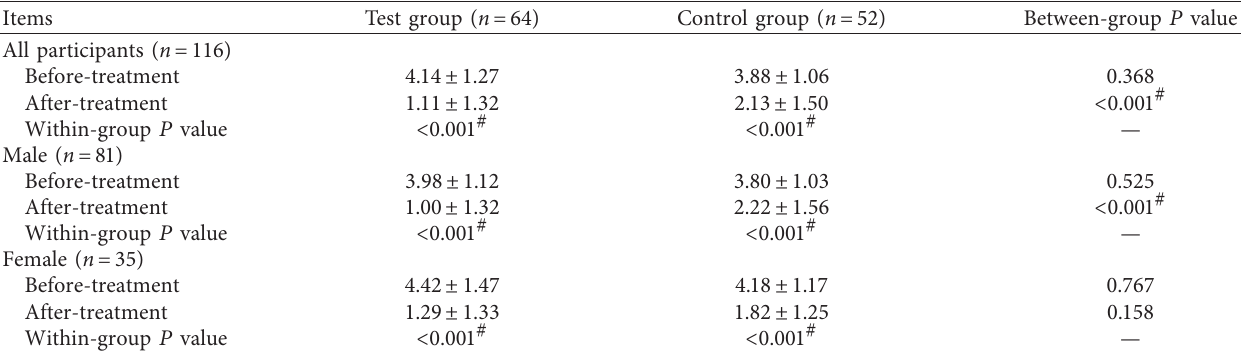
Table 3: VAS pain scores of both groups ( N �